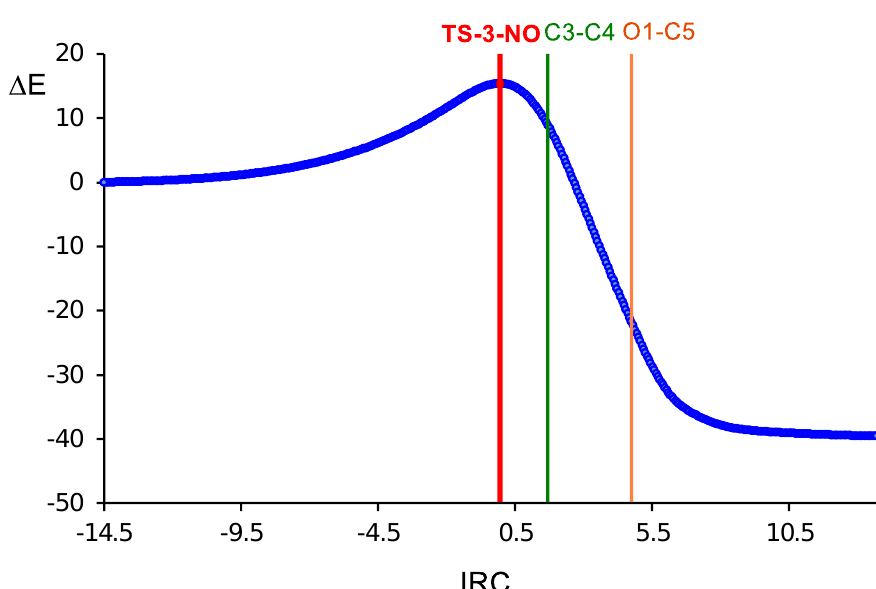
Figure 6. B3LYP/6-31G(d) ELF localisation domains, represented at an isosurface value of ELF = 0.75, of the structures S2-NO and S3-NO involved in the formation of the first C3 − C4 single bond along the 32CA reaction between of phenyl NO 4a and (R)-carvone 1 .